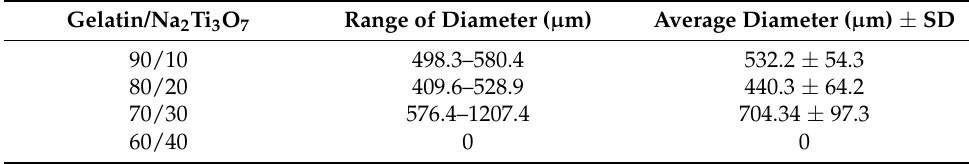
Table 4. The pore size of the scaffolds produced via the salt-leaching